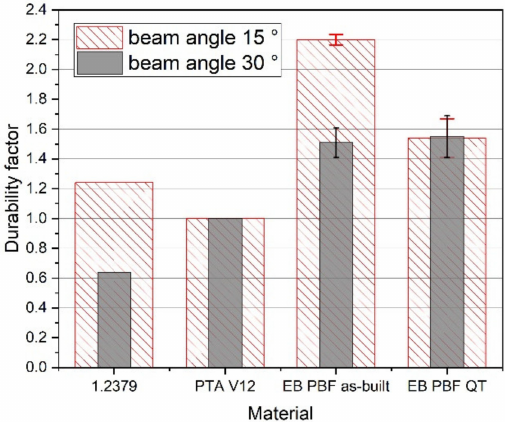
Figure 11. Durability factor dependent on beam angle and material, whereas PTA hard facing is used as reference (factor 1). All PBF-EB samples showed a higher durability.